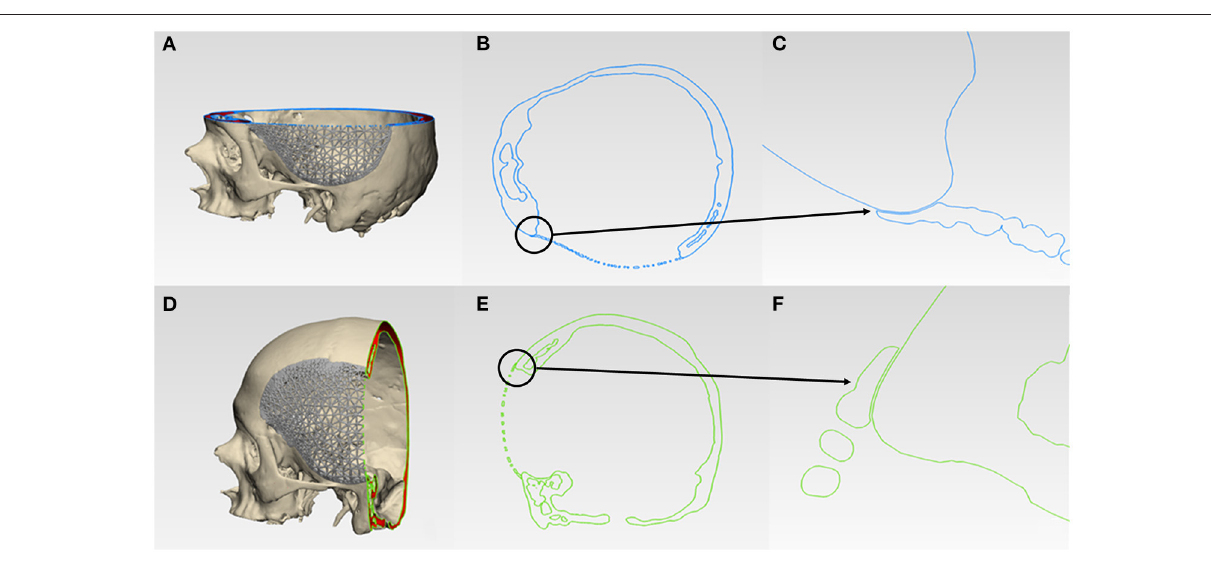
Frontiers in Physiology |